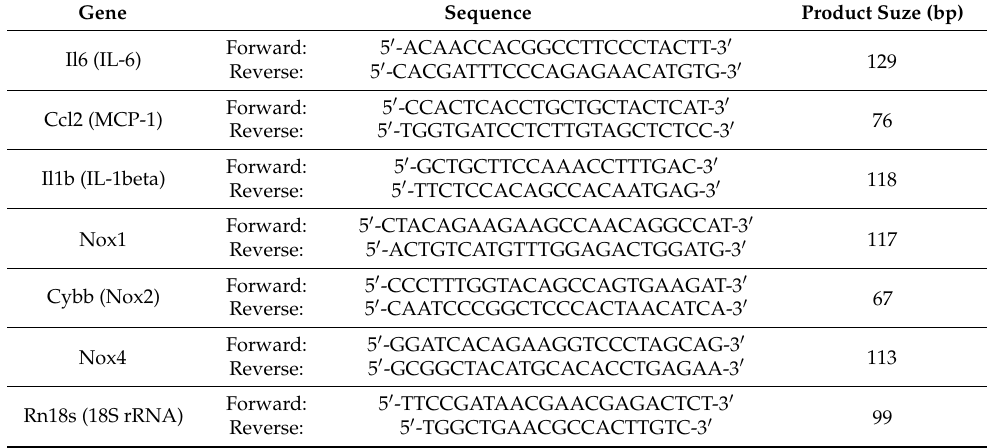
Table 1. Primer pairs for quantitative real-time